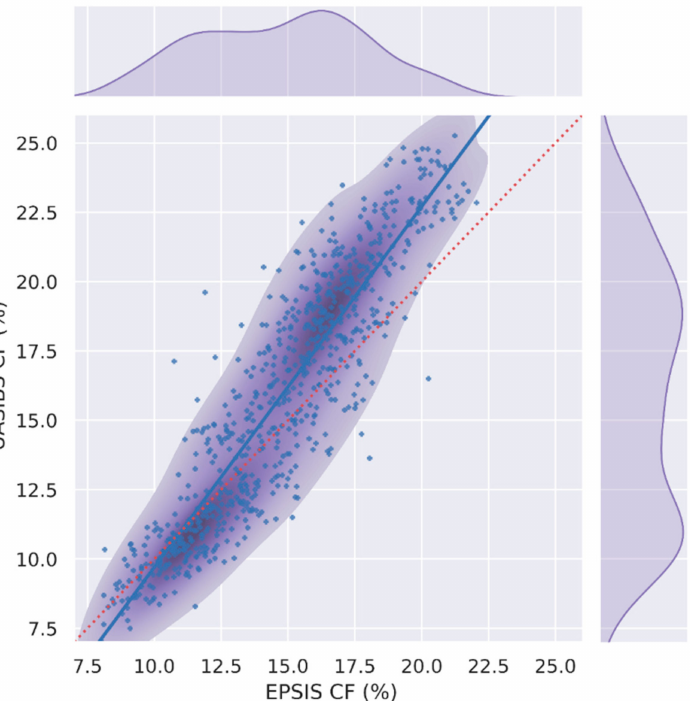
Figure 12. Scatter plot of the annual capacity factors between the EPSIS data and the UASIBS–KIER model estimates with probability density function of frequency for each dataset. The red dotted line indicates the reference line for perfect